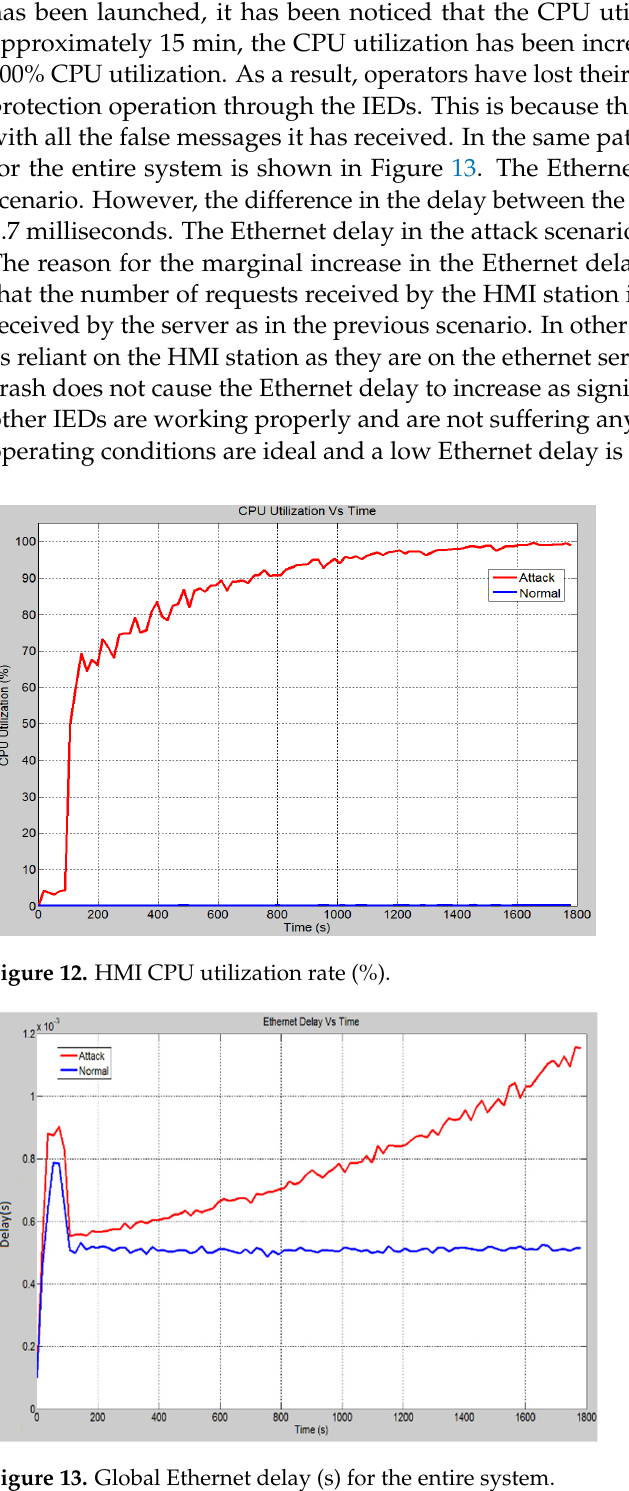
Figure 11. CPU utilization rate (%).